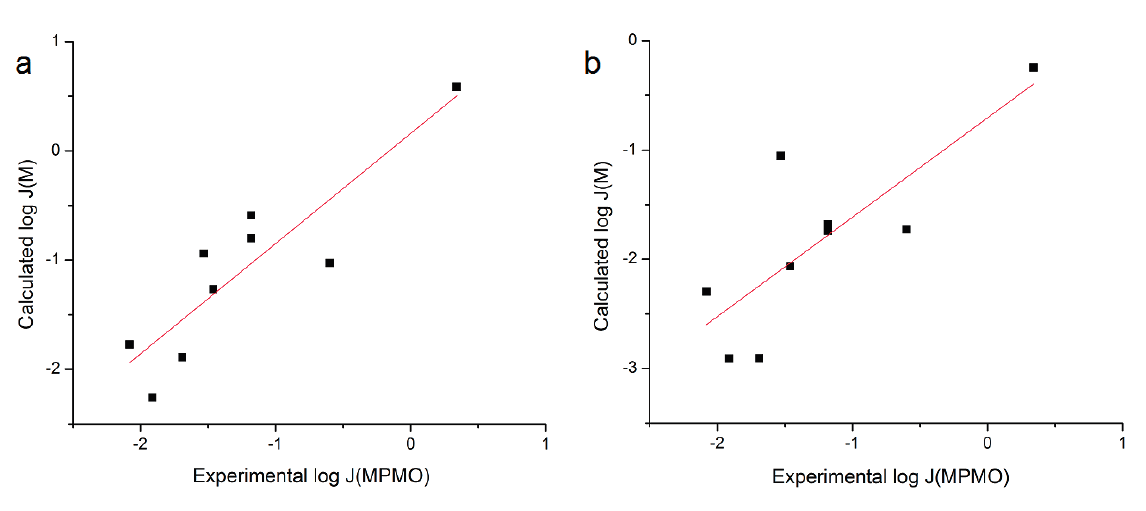
Figure 6. Plot of log J Wenkers and Lippold [7] versus Exp. log J